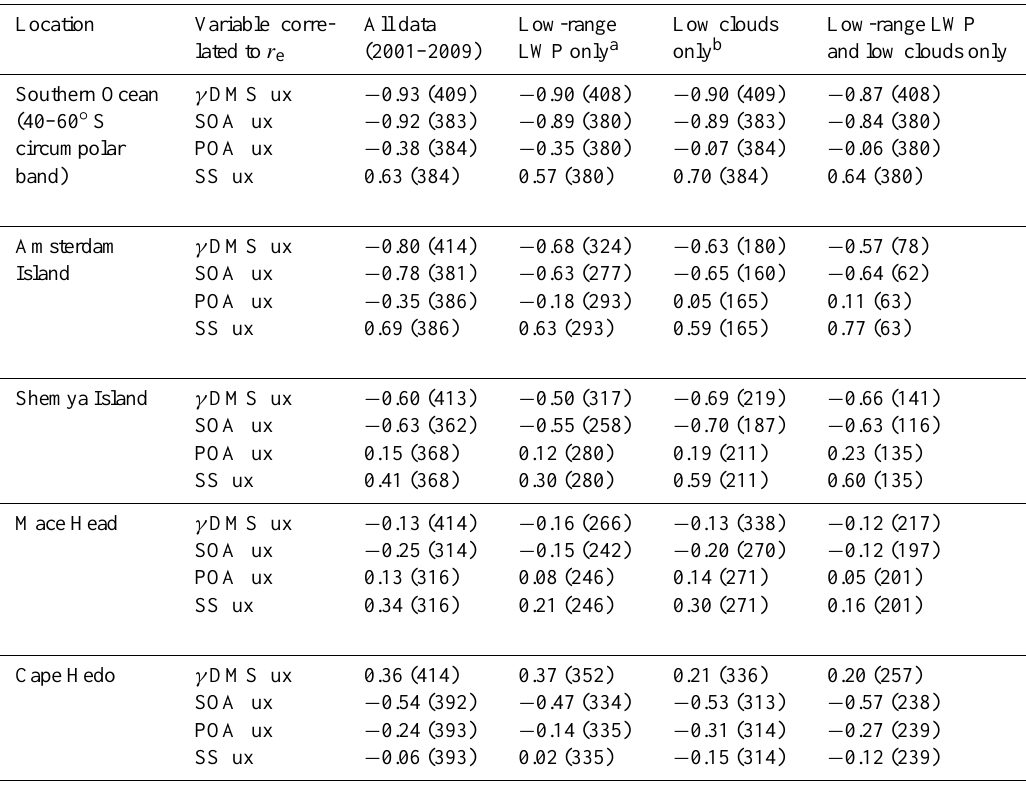
Table 1. Spearman’s rank coefficients of correlation between computed weekly marine aerosol production fluxes and satellite-derived cloud droplet radius ( r e ) in case study regions. Values in parantheses are number of weeks with data.